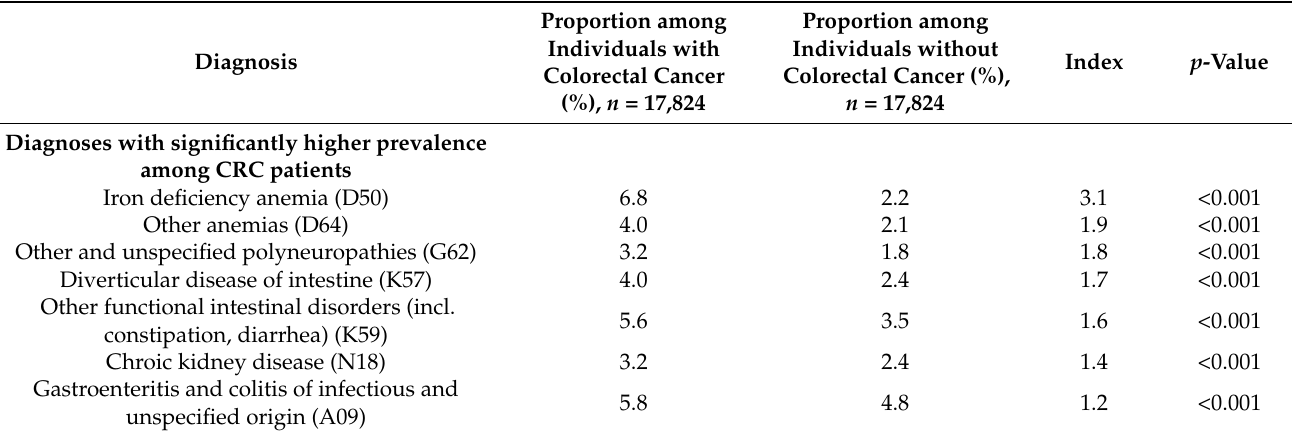
Table 3. Prevalence of different co-diagnoses documented within 12 months after the diagnosis of colorectal